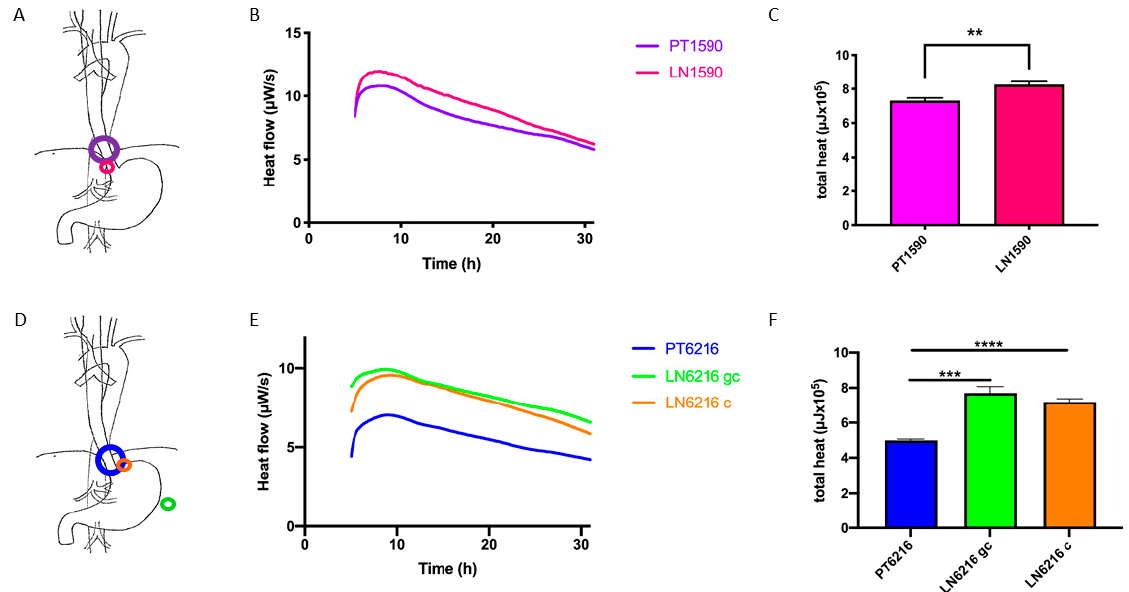
Figure 1. Esophageal carcinoma primary tumor and metastatic cells: location, microcalorimetric profile, and heat production. Cell lines PT1590 and LN1590 originated from the same patient with esophageal adenocarcinoma. LN1590 was derived from a micrometastic lymph node ( A ). Microcalorimetric assessments of tumor cells show an increase thermogenic profile of the metastasis compared to the primary tumor ( B ). This is also displayed in the increased overall heat production of metastatic cells. LN1590 cells have a significantly higher ( p < 0.01 (**)) overall heat production ( C ). Cell lines PT6216, LN6216g, and LN6216c originated from primary tumor and lymph node metastases (LN6216gc, location of lymph node along the great curvature of the stomach; LN6216c, lymph node location at the cardia) of a patient with advance esophageal carcinoma with extensive metastatic spread ( D ). Microcalorimetry shows a higher heat flow rate for all metastatic cell lines compared to the primary tumor cell line ( E ). Both metastatic cell lines LN6216c and LN621gc have a significantly higher overall heat production ( p < 0.0001 (****) and p < 0.001 (***), respectively) compared with the primary tumor cell line ( F